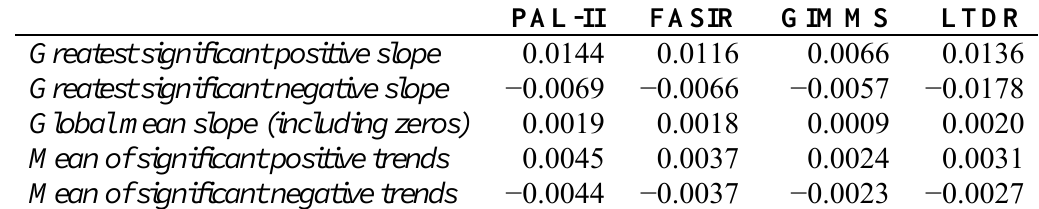
Table 3. Differences in the magnitude of the 1982-1999 NDVI significant trends across four AVHRR datasets for the Iberian Peninsula. Significant trends were considered for p-values < 0.05 by means of the seasonal Mann-Kendall trend test. Slopes express change of NDVI per year.